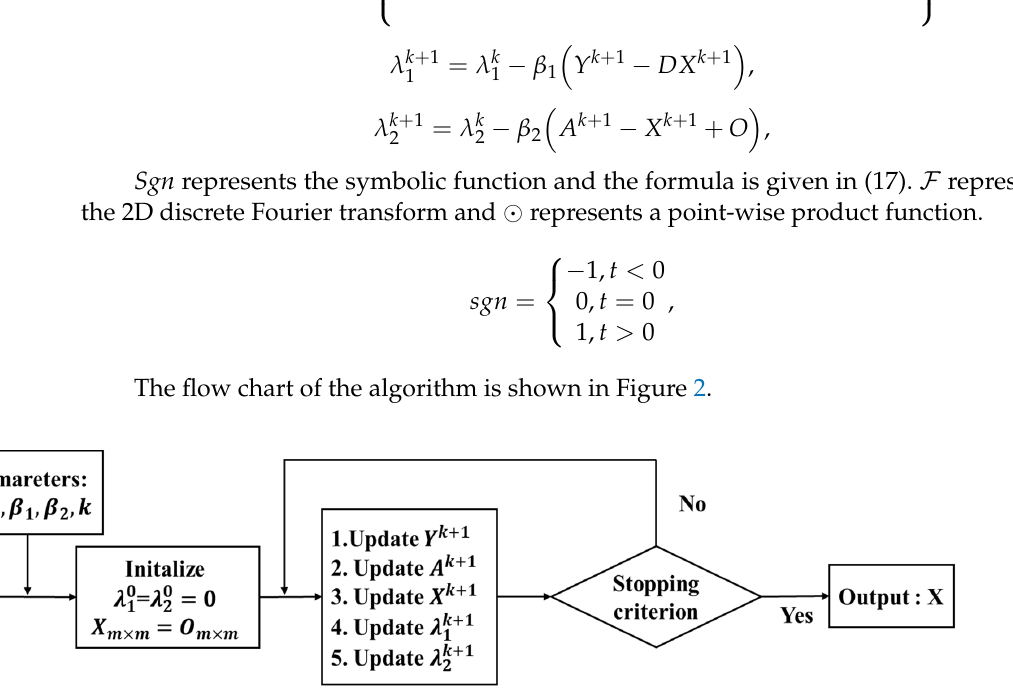
Figure 2. The flow chart of the ND ‐ SGC method.